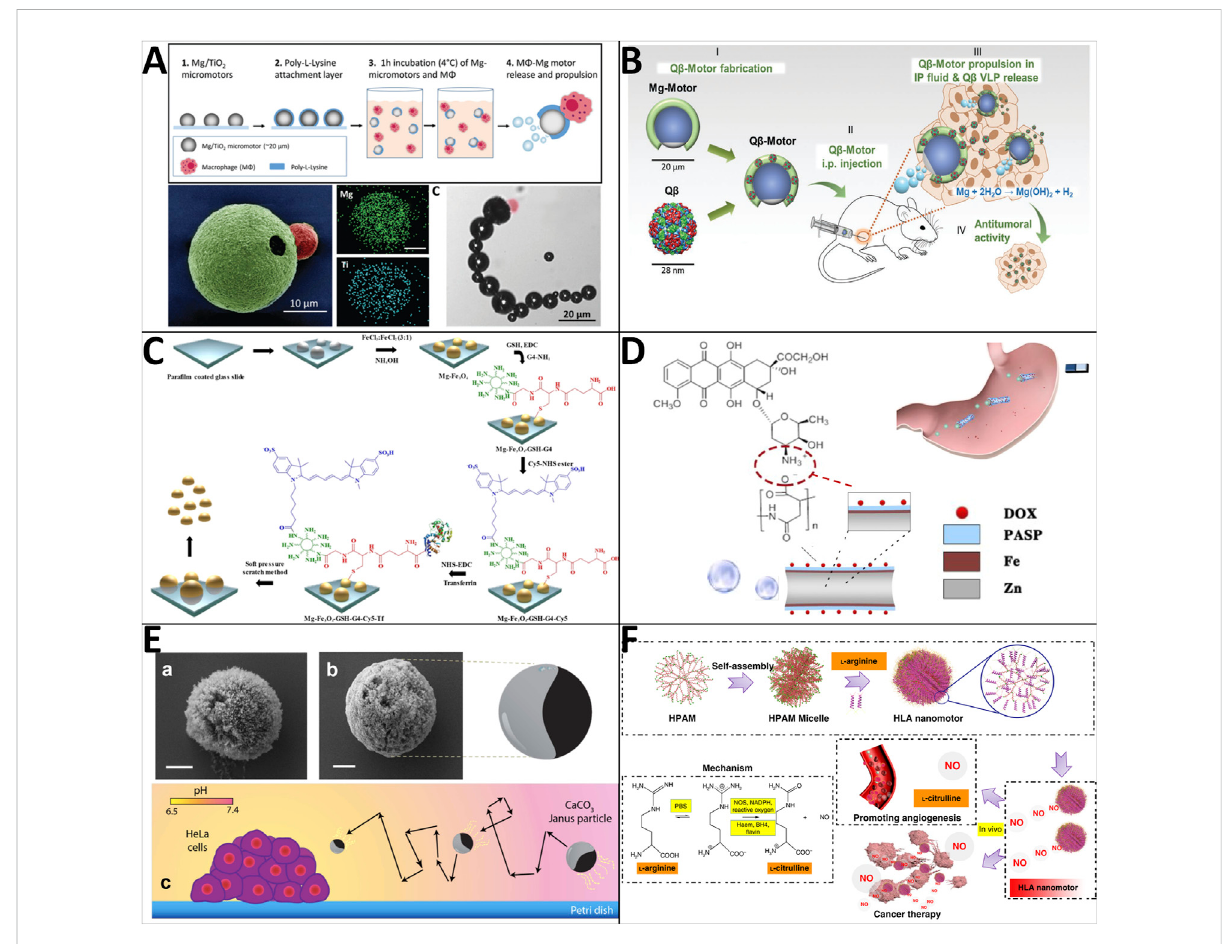
FIGURE 4 Motile drug delivery by biocompatible fuel-powered MNRs. (A) Macrophage-magnesium biohybrid micromotor. (Zhang et al., 2019) Copyright 2019. Reproduced with permission from John Wiley and Sons. (B) Bacteriophage virus-like nanoparticles (Q β VLPs)-loaded Mg-based micromotors. (Wang C et al., 2020) Copyright 2020. Reproduced with permission from John Wiley and Sons. (C) Mg-Fe 3 O 4 -based Magneto- fl uorescent nanorobot.(Wavhaleetal.,2021)Copyright2021.TheAuthors,somerightsreserved;exclusivelicenseeSpringerNature. (D) Poly(asparticacid)/ iron-zinc microrockets. (Zhou et al., 2019) Copyright 2019. Reproduced with permission from American Chemical Society. (E) Calcium carbonate micromotors. (Guix et al., 2016) Copyright 2016. The Authors, some rights reserved; exclusive licensee Springer Nature. (F) NO-driven nanomotors. (Wan et al., 2019) Copyright 2019. Reproduced with permission from Springer